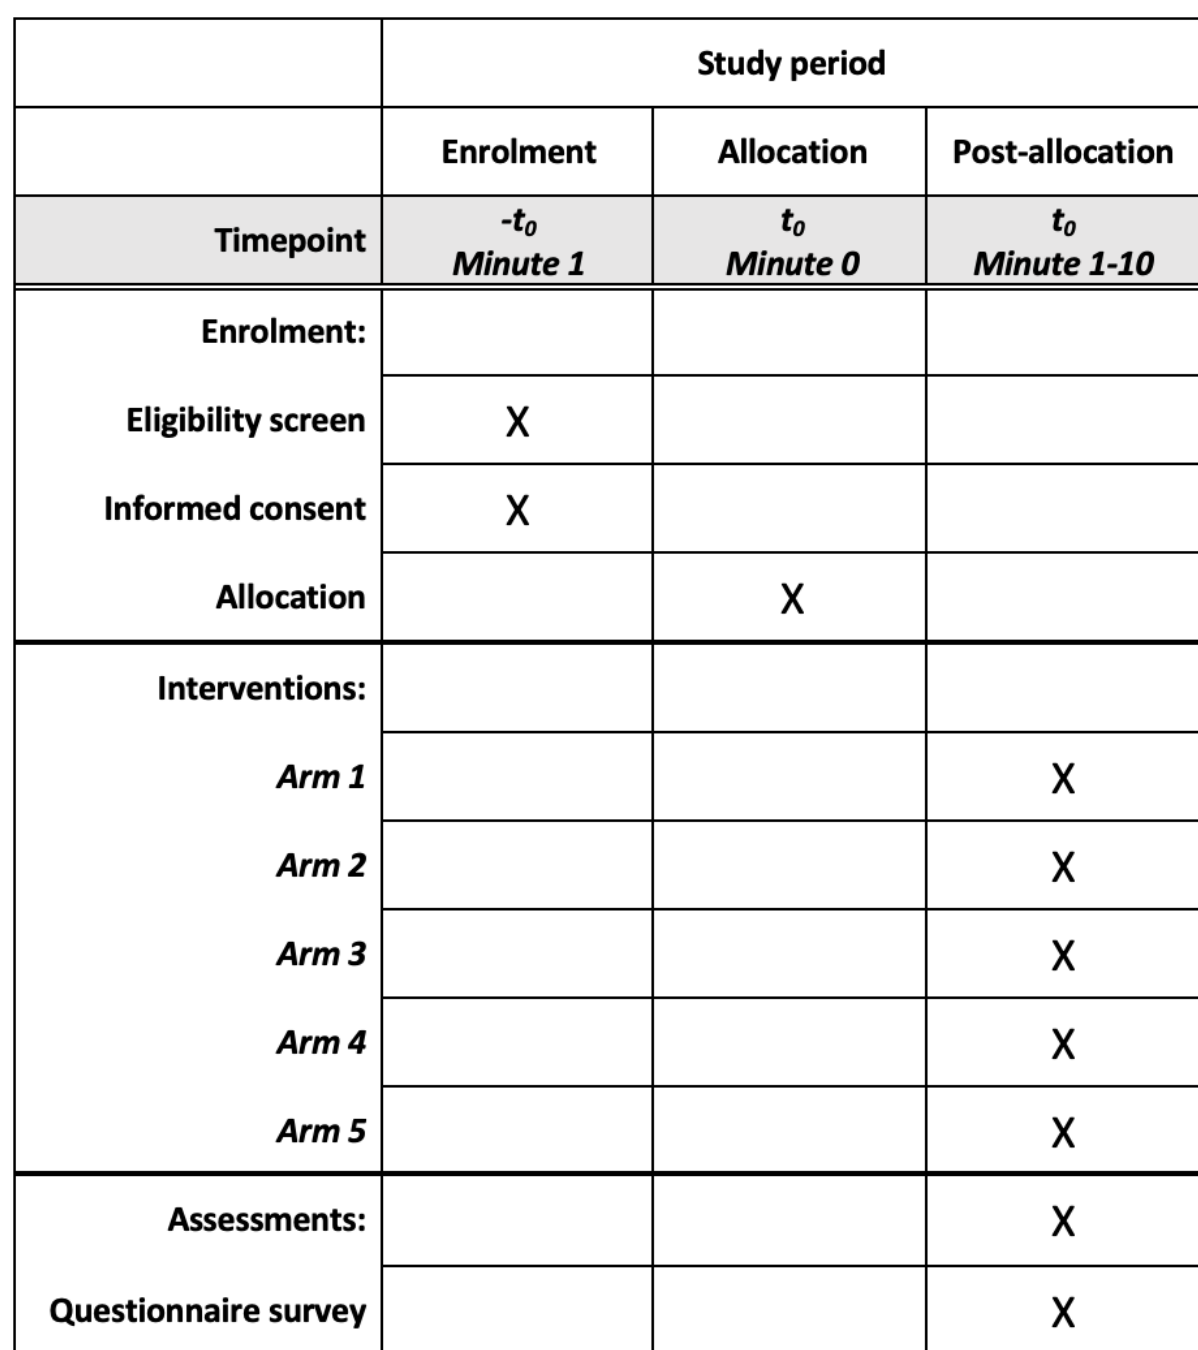
Figure 3. Schedule of enrollment, interventions, and